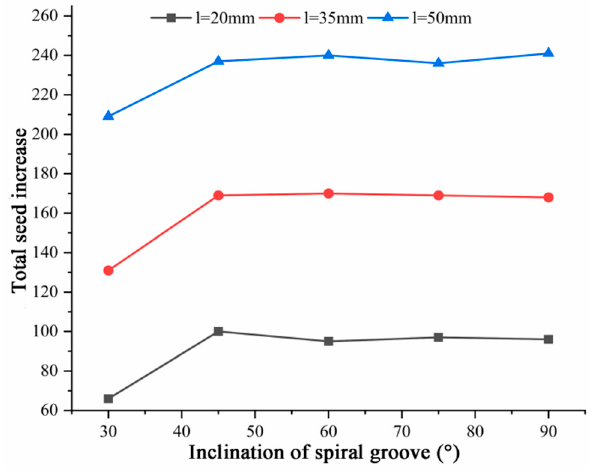
Figure 11. Effect of spiral groove inclination change on seed increment.